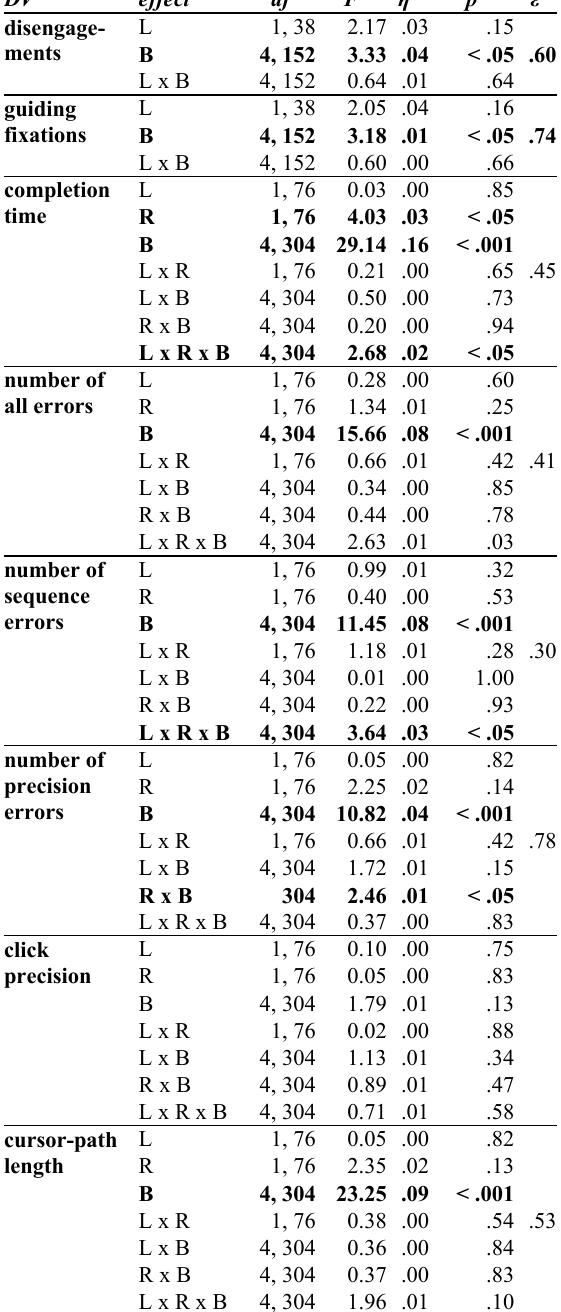
Table 8. ANOVA results of the recall phase of Experiment